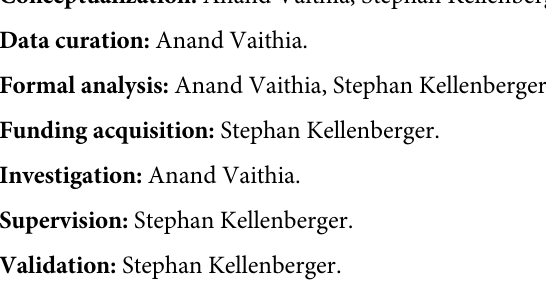
S1 Table. Length of MTS cross-linkers and monovalent reagents. The length of each MTS cross-linker or monovalent reagent was determined as the distance between the Sulphur atoms on both ends after the release of sulfinic acid (SO CH ; for cross-linkers), and between 2 3 the Sulphur atom and the other end of the molecule (monovalent MTS reagents). S2 Table. Selection of MTS cross-linkers and monovalent MTS reagents for the different mutants. The indicated MTS cross-linkers were chosen for each mutant, based on the match between the cross-linker length and the distance between engineered Cys in the open (4NTW), desensitized (4NYK) and closed state (5WKU) models of human ASIC1a. Monova- lent MTS reagents of similar length were chosen as controls. #, the length of the reagent matches the Cys-Cys distance of the desensitized state. S3 Table. Summary of functional information obtained from previous studies using mono- valent MTS reagents on ASIC1a